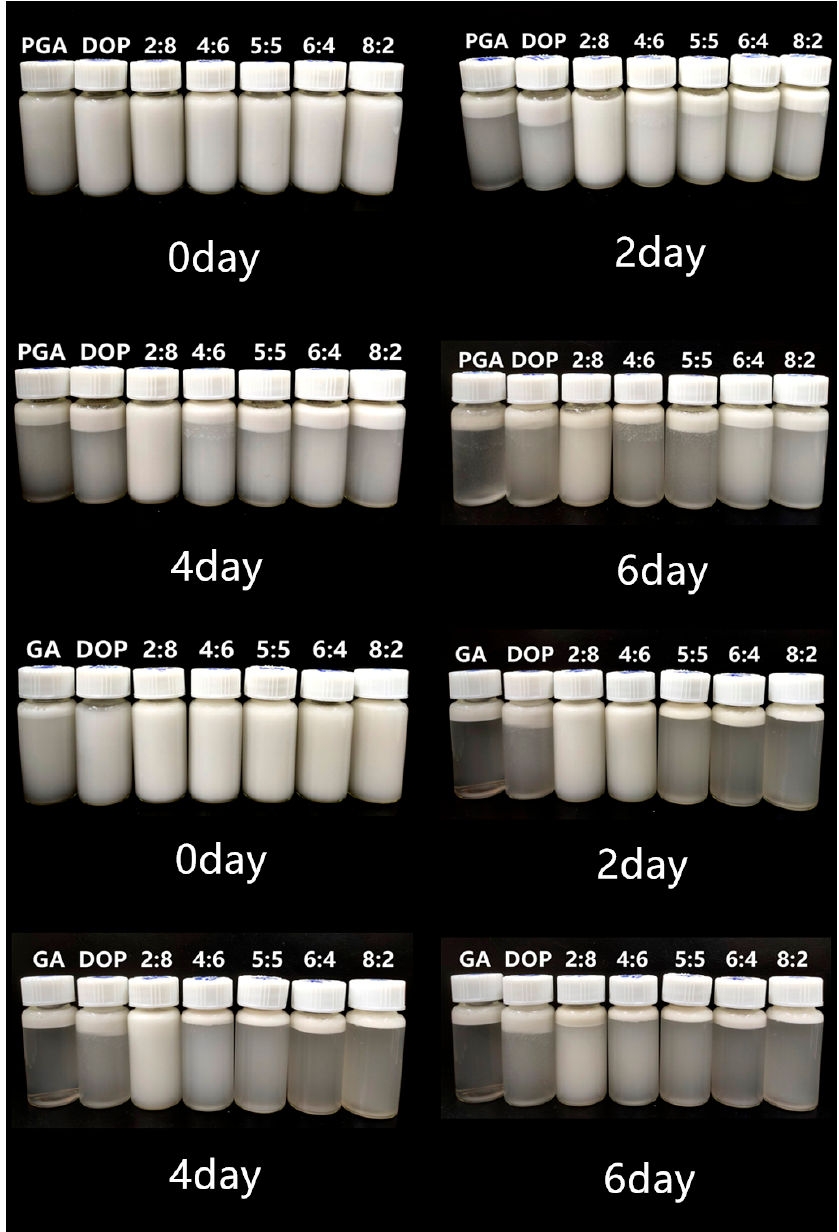
Figure 6. Visual observations (total emulsifier concentration was 1 wt%).